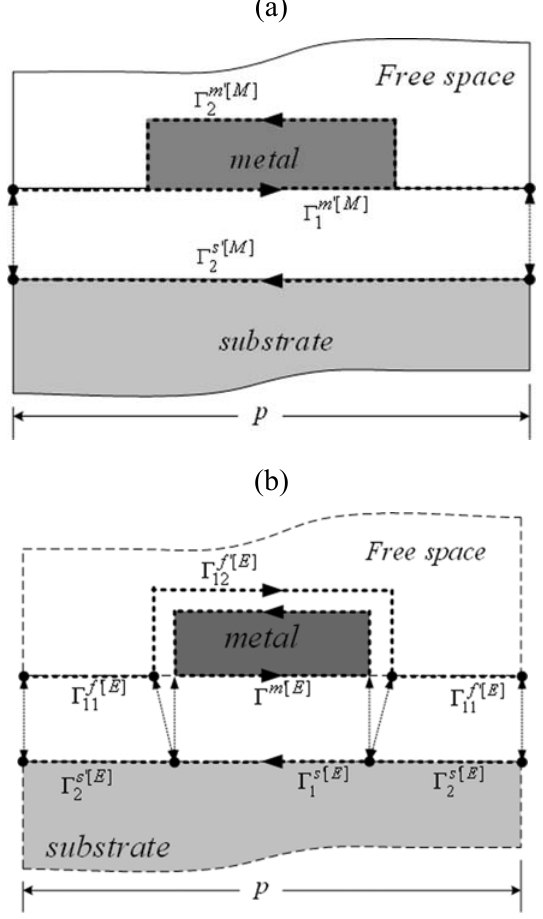
Figure 2. Boundary conditions for theoretical analysis: (a) Mechanical boundary